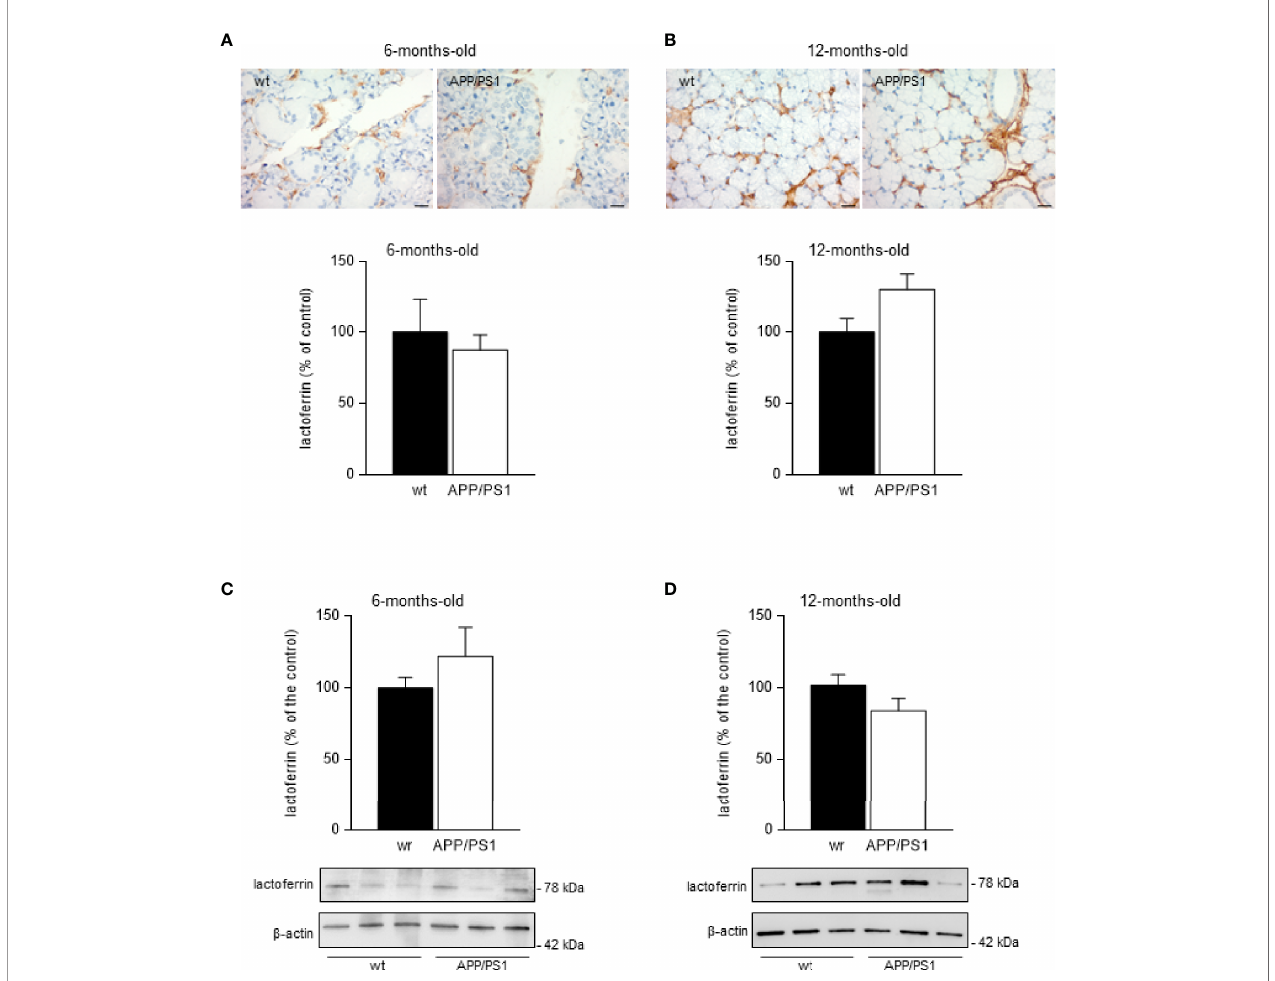
FIGURE 2 | Lactoferrin levels in mice submandibular glands. (A, B) Lactoferrin stained (brown) sections of submandibular glands from (A) 6- and (B) 12-month-old APP/PS1 and WT mice. Size bar 20 m m. All sections were counterstained with haematoxylin (blue). In the lower histograms, quanti fi cation of the lactoferrin signal from 6- and 12-month-old APP/PS1 and WT mice submandibular glands, respectively ( n = 8, per group) is shown. (C, D) Western blot analysis showing lactoferrin levels in submandibular glands from (C) 6- and (D) 12-month-old APP/PS1 and WT mice ( n = 12-18, per group). Representative Western blots (lower panels) and histograms with their densitometric analysis (upper panels) are shown. Data are represented as mean ± SEM. Differences between groups were assessed using the Mann-Whitney